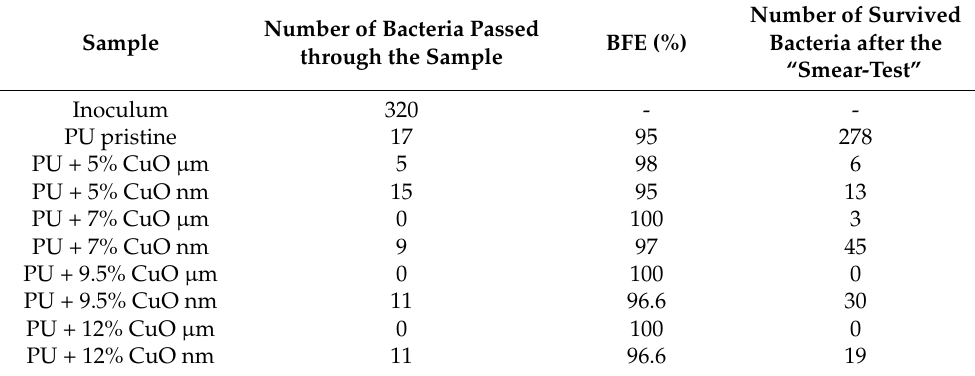
Table 6. Results of the bacterial filtration test and “smear-test” for samples produced from the rotating electrode with a needle surface.